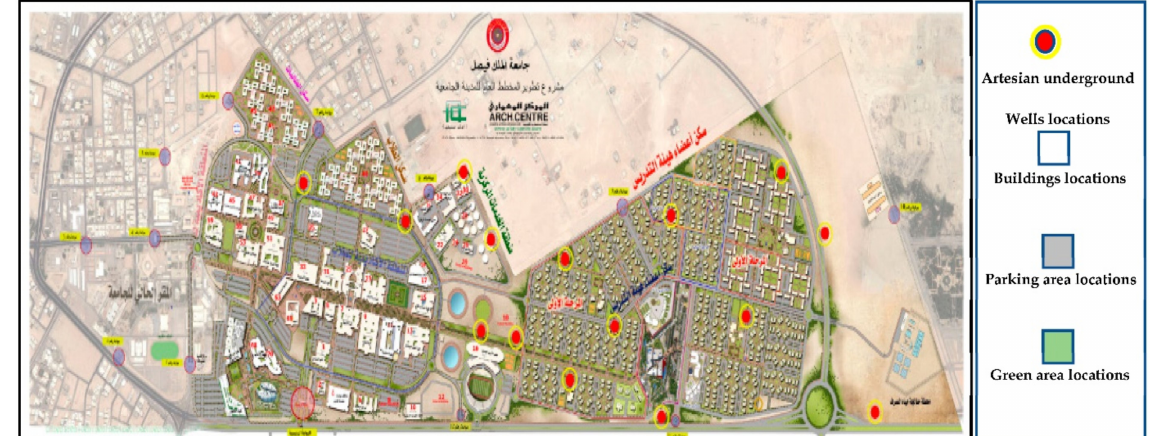
Figure 2. Groundwater artesian wells locations inside King Faisal University